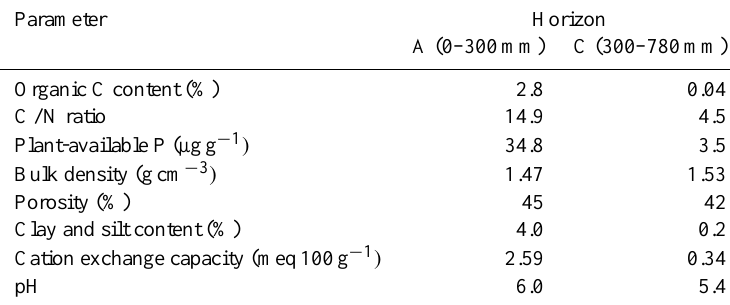
Table 1. Soil properties. The soil bulk density and porosity were determined from samples collected from the mesocosms. All remaining parameters were measured prior to filling of the